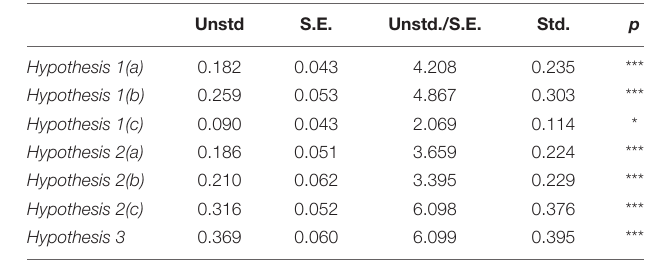
TABLE 9 | Regression